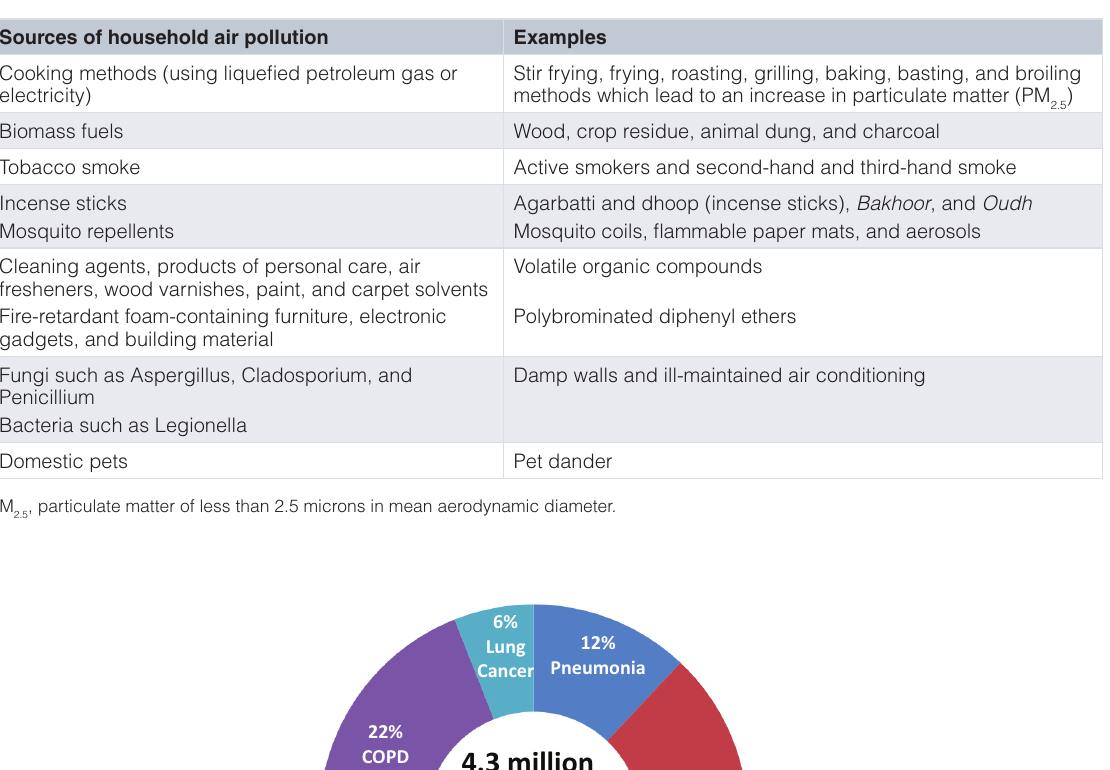
Table 1. Sources of household air